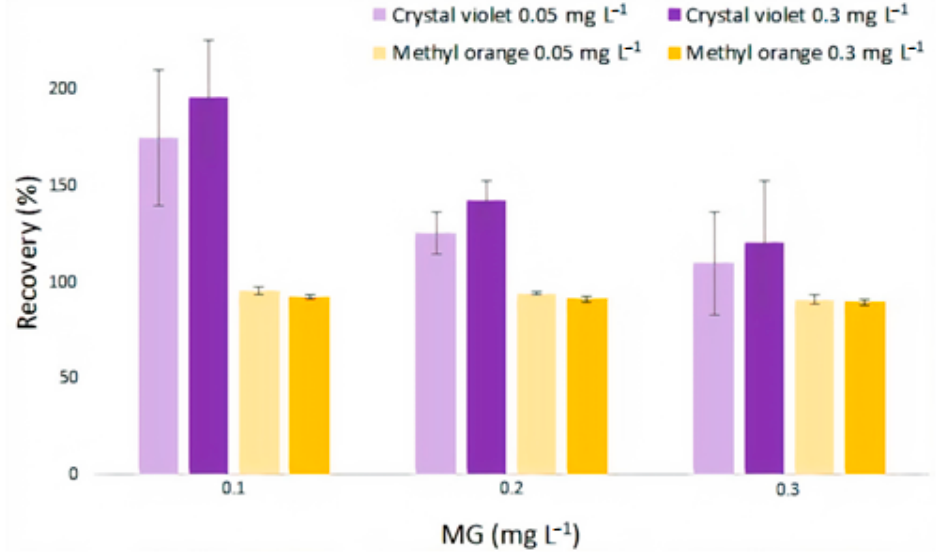
Figure 10. Recovery of MG in the presence of crystal violet and methyl orange.